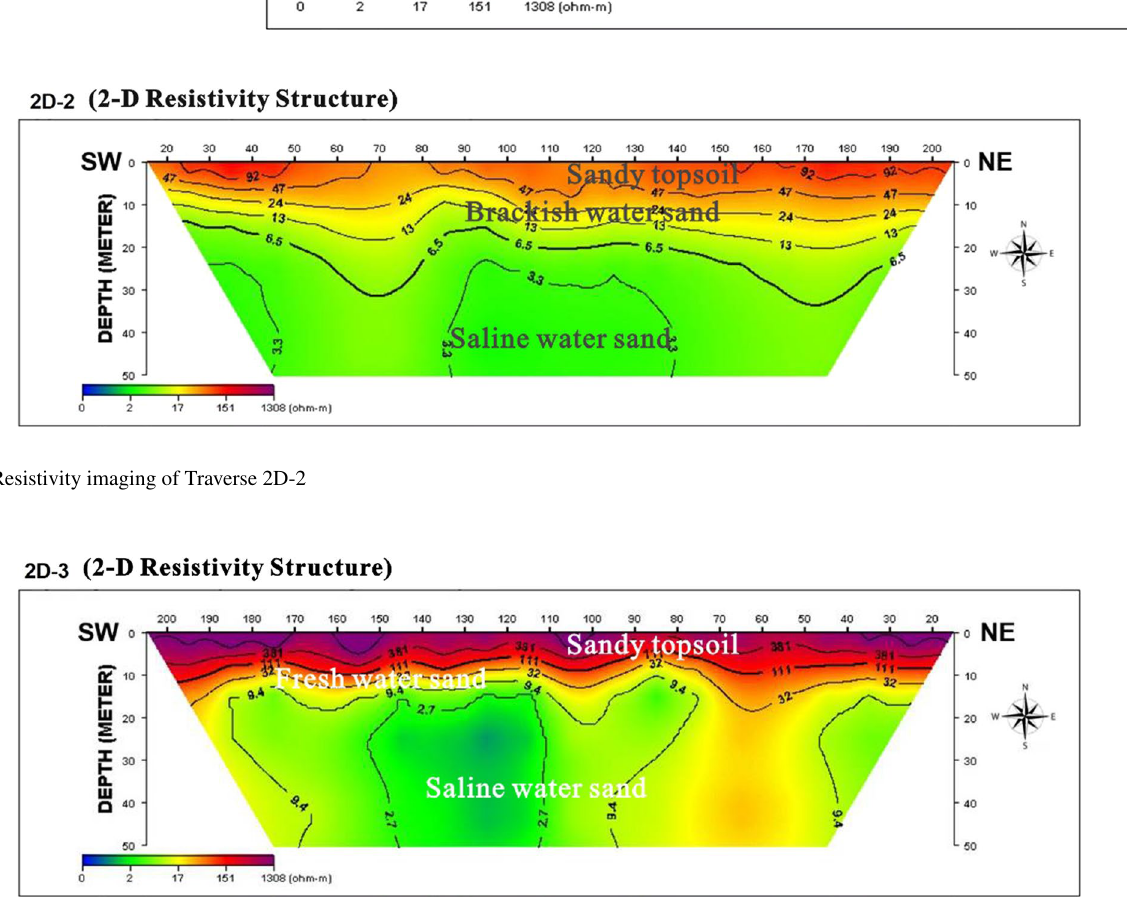
Fig. 7 Resistivity imaging of Traverse